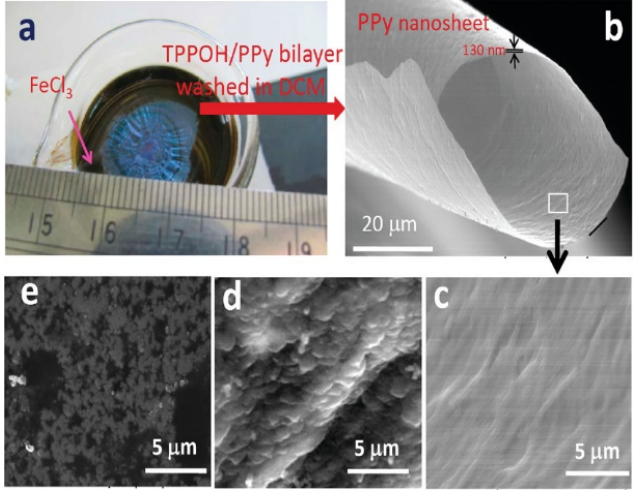
Figure 5. ( a ) Photograph of the TPPOH/PPy bilayer formed at the air/FeCl 3 interface film, ( b ) SEM images: PPy-2 film, ( c ) magnified image of PPy-2 film, ( d ) J-aggregate film of TPPOH, and ( e ) PPy-1 films that are formed without TPPOH [91]. Copyright 2011